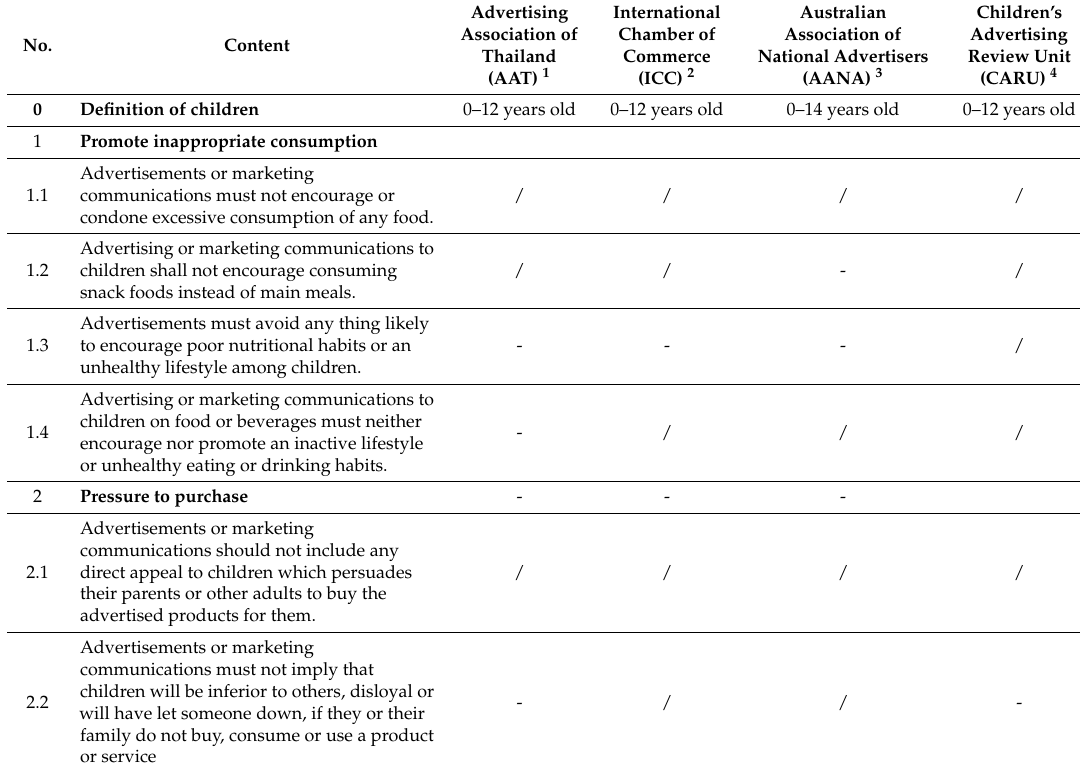
Table A2. Overview of industry self-regulatory